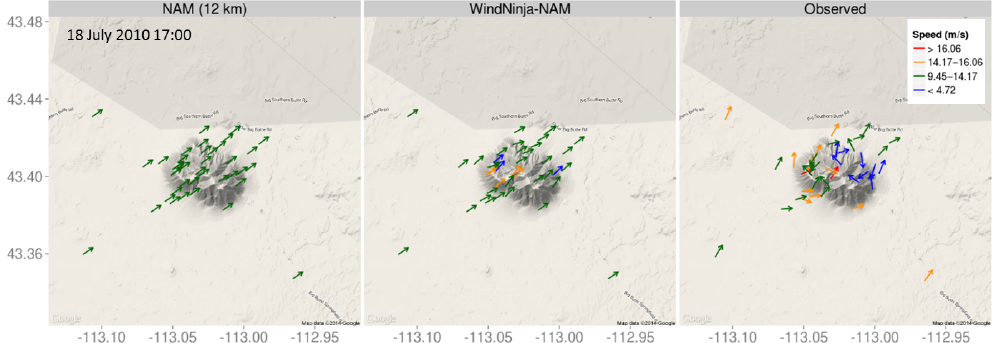
Figure 6. Predicted and observed winds for an externally forced flow event at Big Southern Butte.